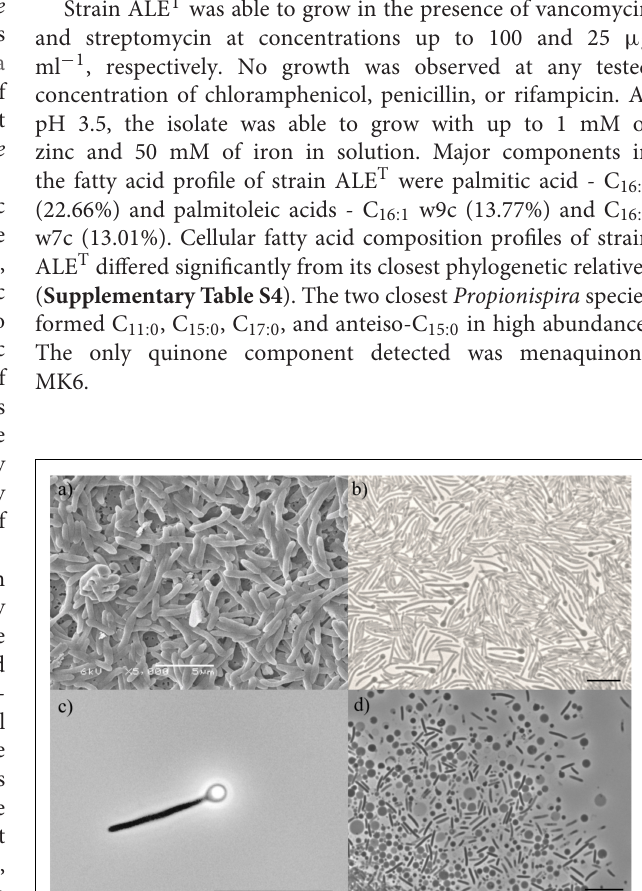
Frontiers in Microbiology |